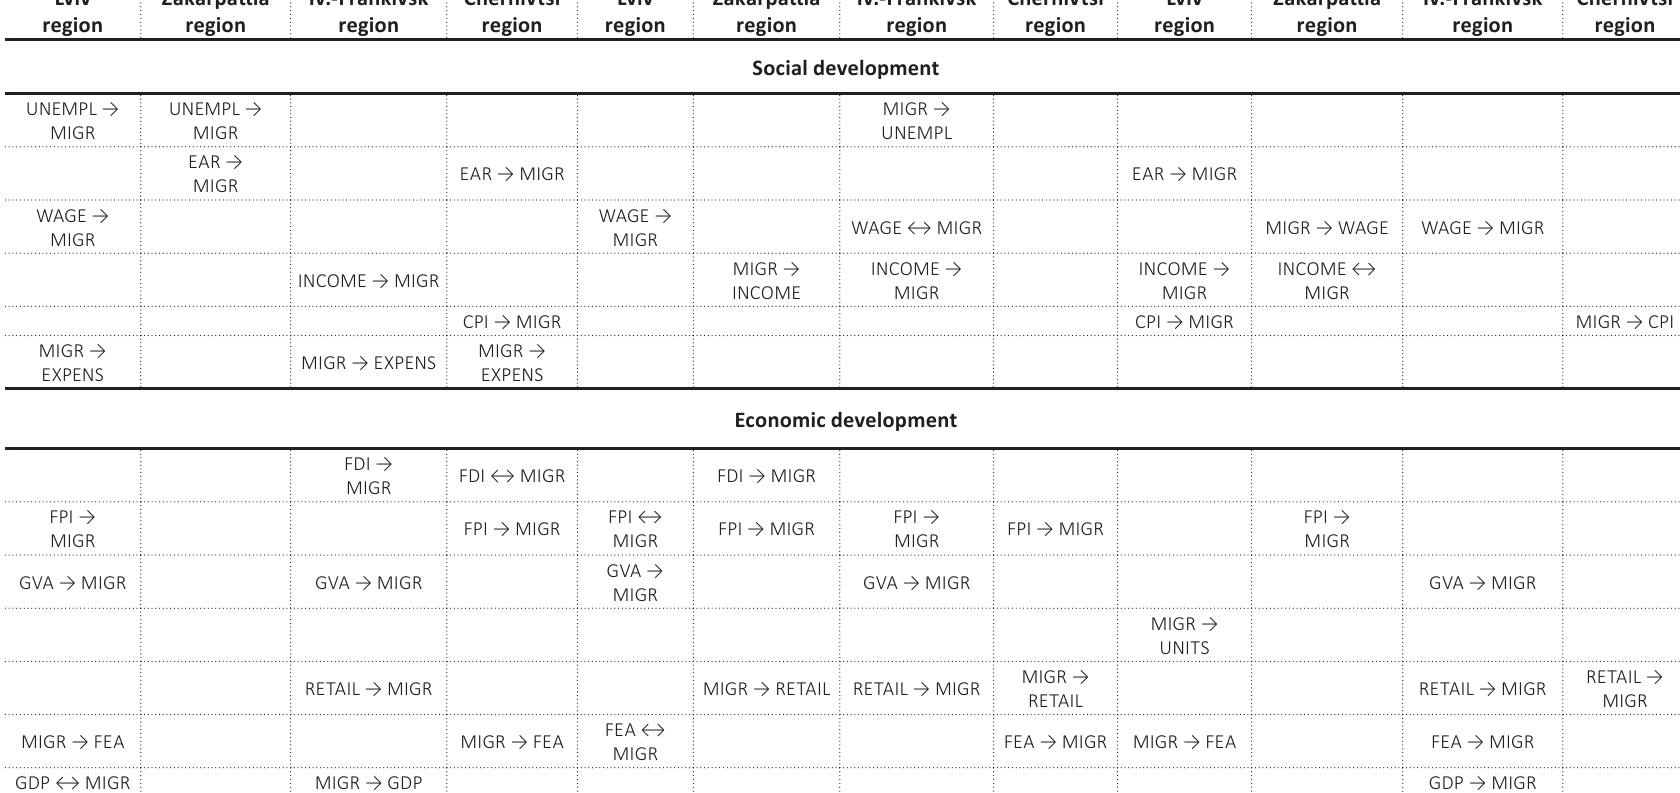
Source: Based on data in Tables A1 and